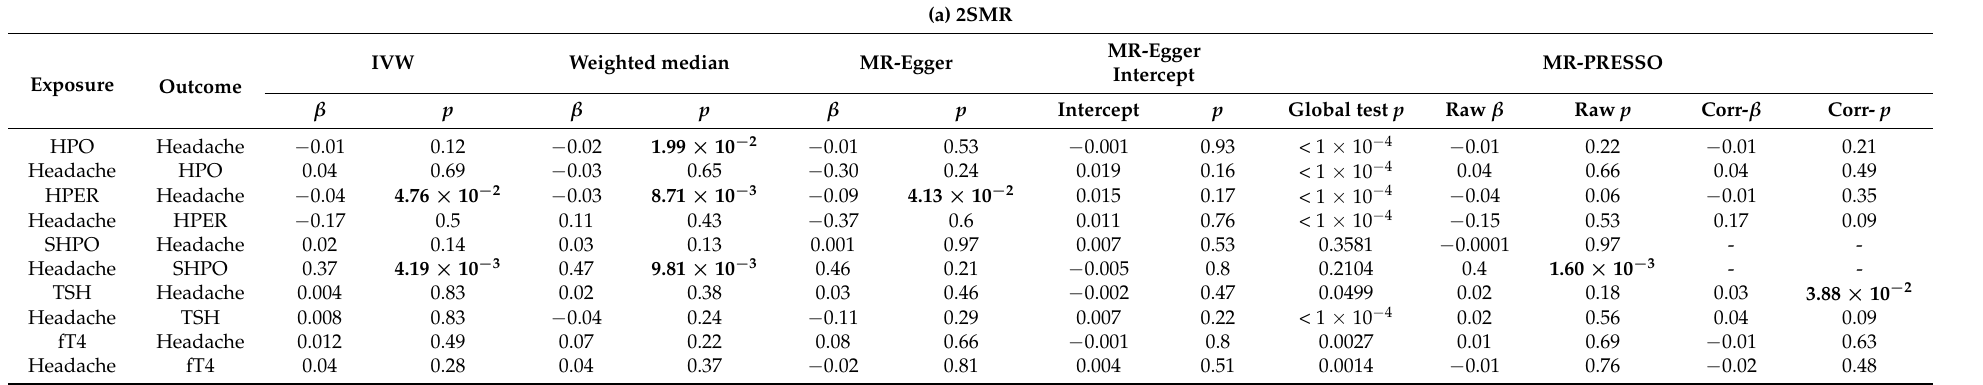
Table 3. MR results for headache and thyroid